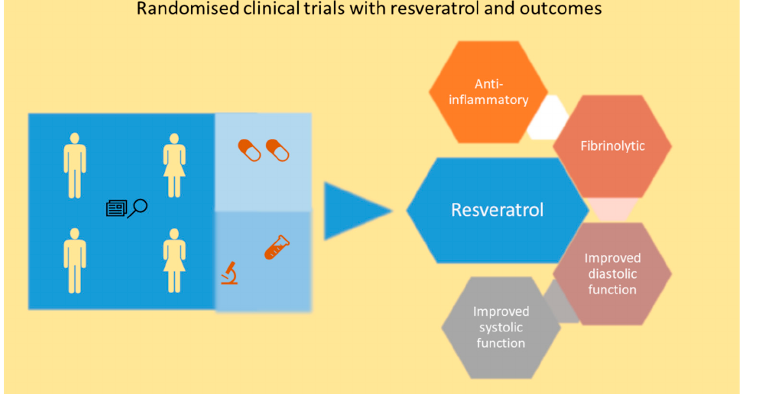
Figure 3. Schematic depicting the resveratrol mediated improvement in clinical parameters in randomized clinical trial in CAD and HF patients. Resveratrol reduces pro-inflammatory markers and induces fibrinolysis in CAD patients. Resveratrol also improves diastolic and systolic function in CAD and HF patients. A double-blinded, placebo-controlled, randomized, three-month clinical study showed that resveratrol treatment in 40 post-MI patients including 26 men and 14 women was able to improve diastolic function and systolic function. The study consisted of placebo and 10 mg/day resveratrol group, and both groups also received routine post-MI medication. Endothelial function, red blood cell deformability, LDLC and platelet aggregation were also improved in resveratrol treated group [137]. TC, HDLC, TG and high-sensitivity C-reactive protein (h-CRP) were not affected with resveratrol treatment. Calcium fructoborate (CF) is a dietary supplement that has calcium, fructose, and boron in a sugar-borate ester as the three main ingredients with anti-inflammatory action [138]. A clinical trial also studied the efficacy of three-month treatment with resveratrol and CF in 116 patients with stable angina pectoris [139]. Twenty-nine patients in three groups received placebo treatment, or 20 mg/day resveratrol alone, or a combination of 20 mg/day resveratrol and 112 mg/day CF, or 112 mg/day CF. Treatment led to reductions in h-CRP and the N-terminal pro-hormone of BNP in all three groups. LDLC and TG were also lower in all the treatment groups. CF and resveratrol treatment led to lower incidence of angina episodes, and the number of weekly nitroglycerin consumption, and better angina class. Due to the relatively shorter duration of the trial, it was not possible to ascertain long-term effects of resveratrol treatment. Another randomized trial with 85 CAD patients also reported the effects of resveratrol treatment at a dose of 100 mg per daily (added to standard treatment) for two months. CAD patients treated with resveratrol had improved diastolic function and systolic function [140]. A randomized, triple-blinded, placebo- controlled trial with 75 stable angina patients who received either a regular grape extract or a grape extract containing resveratrol for one year showed benefits such as reduction in pro-inflammatory biomarkers and improved anti-inflammatory and fibrinolytic biomarkers [141]. The grape extract (350 mg/day) containing 8 mg resveratrol was given in the initial 6 months and followed by grape extract (700 mg/day) containing 16 mg resveratrol for next 6 months of the study. Patients also received standard medication. Resveratrol treatment increased adiponectin and decreased plasminogen activator inhibitor type 1 [141]. It also resulted in a down-regulation of pro-inflammatory genes and changes in transcription factors and miRs in two subpopulations of patients in the trial [142]. The lipid profiles of the patients were also improved with treatment [142]. The first two studies are particularly interesting due to the fact that the concentration of resveratrol